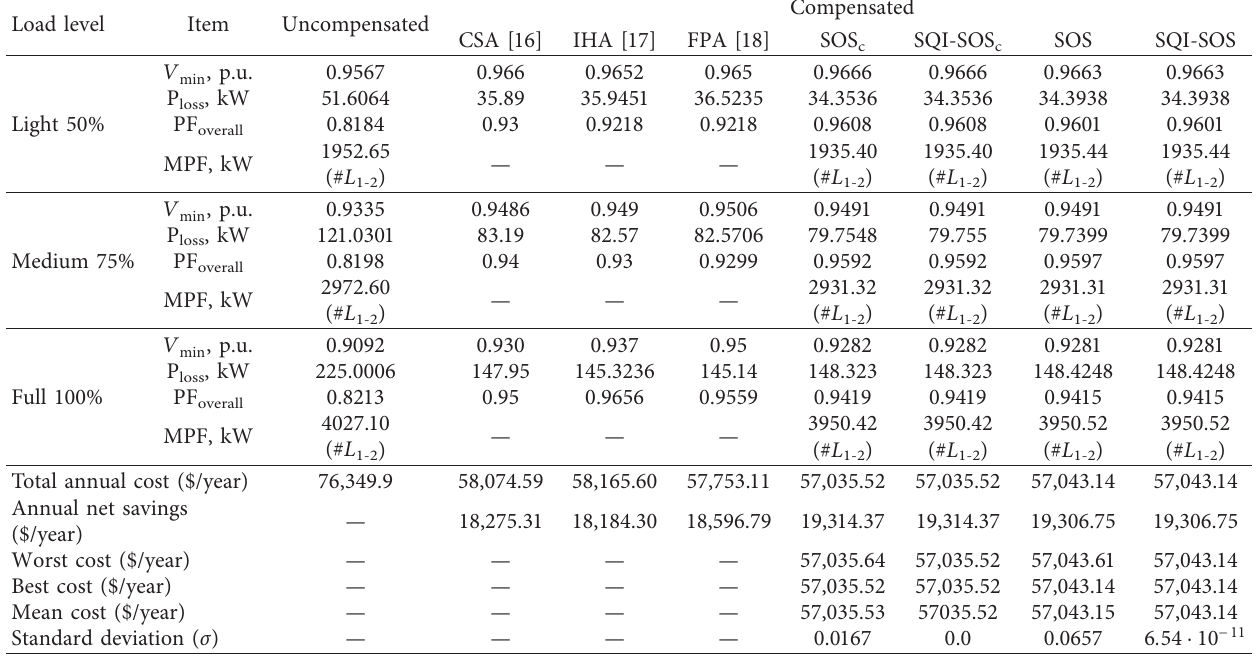
Table 11: Comparison results of the 69-bus system before and after compensation with the CP load model at different load levels. Load level